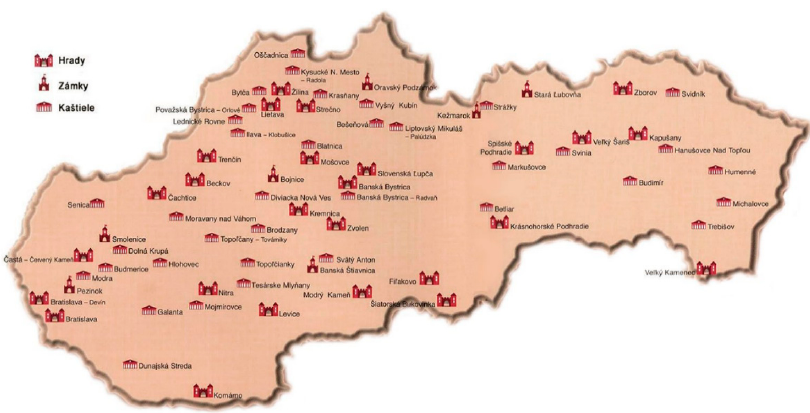
Figure 2. Cultural and historical objects in Slovakia (Source 3